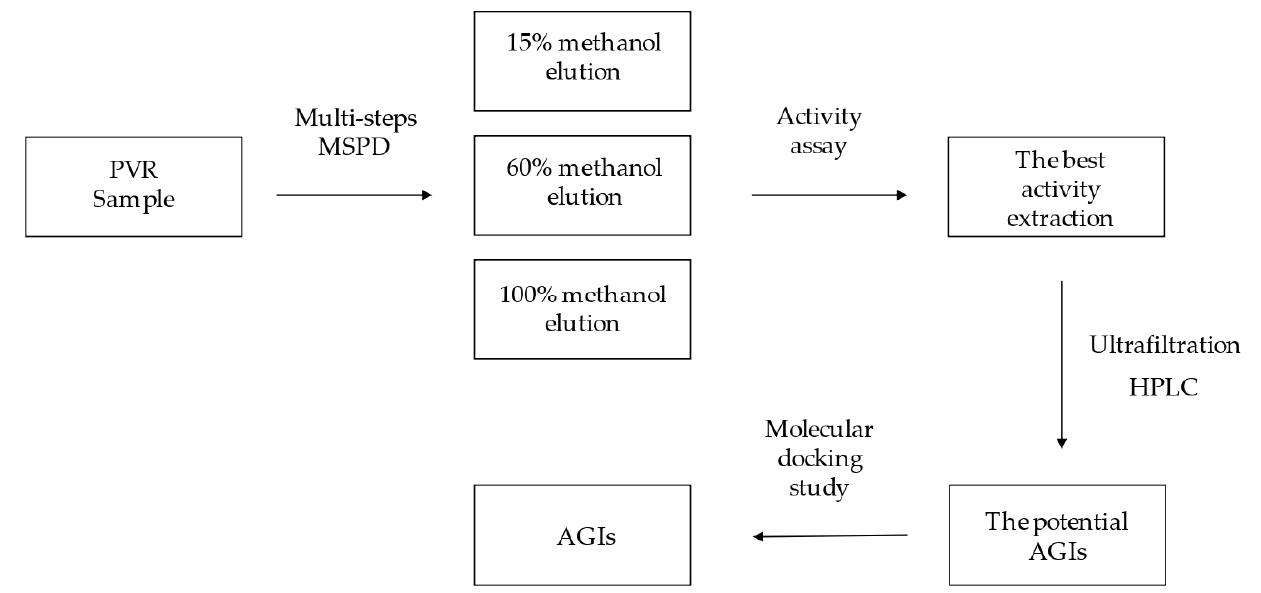
Figure 6. Schematic diagram of multi-step MSPD, ultrafiltration and HPLC.